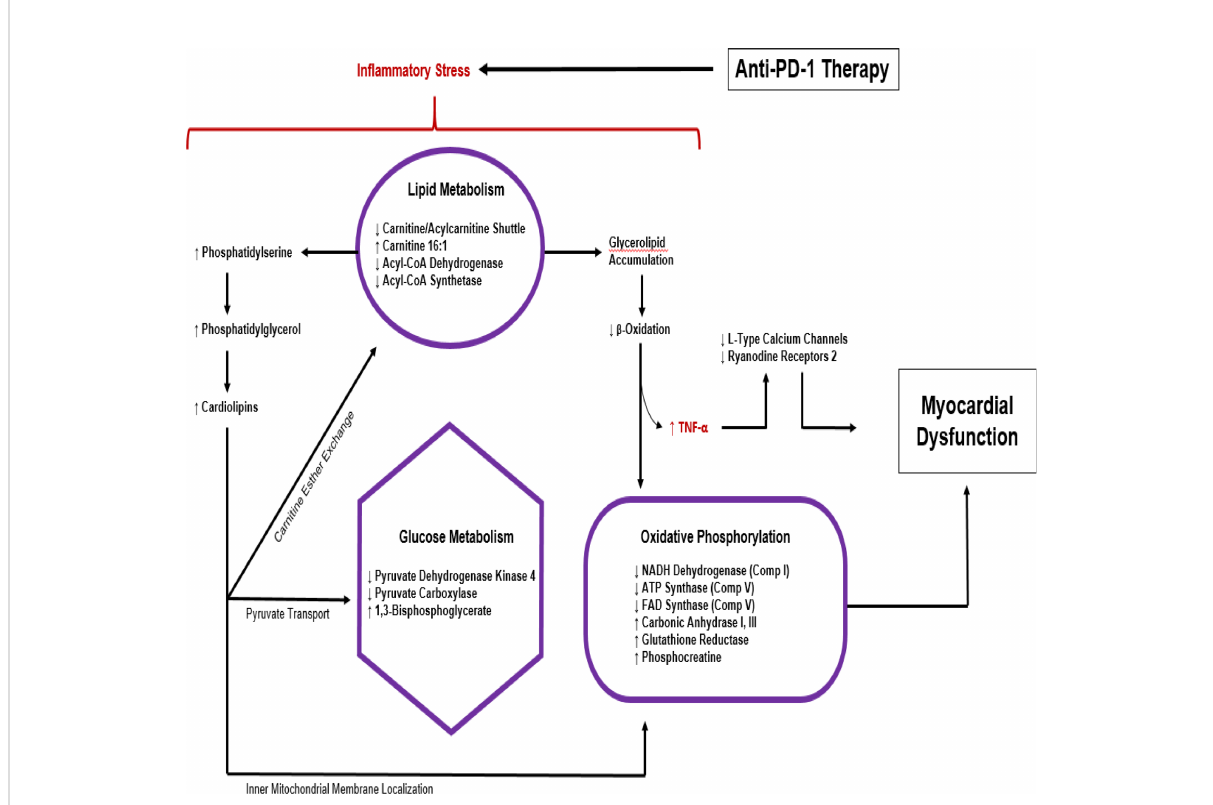
FIGURE 4 Metabolic response to anti-PD1 therapy based on substrate analysis in experimental model (70,